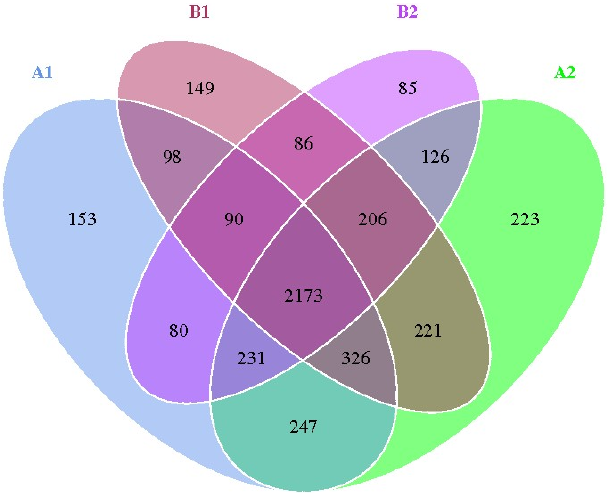
Figure 7. Venn diagram of OTU numbers of different soil samples.